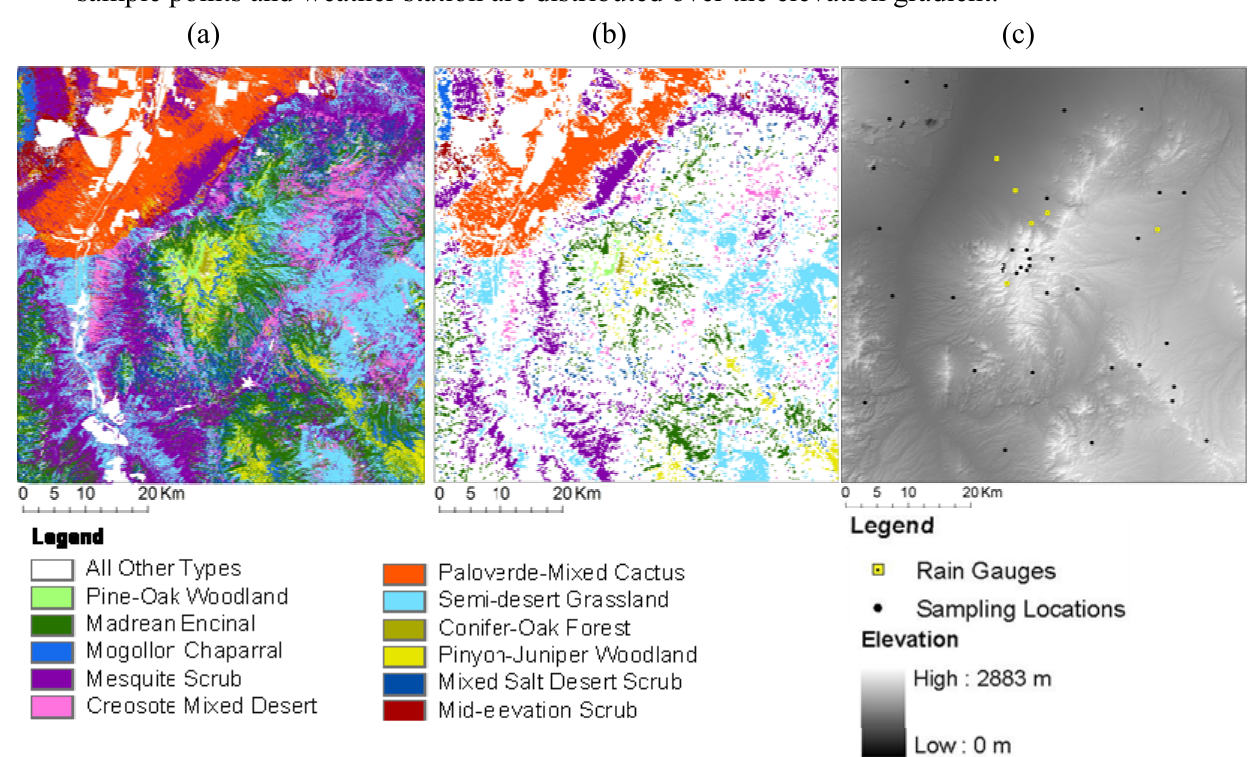
Figure 2. (a) The vegetation communities based on the SWReGAP vegetation cover map are dominated by the 11 (b) communities used in our analysis (see also Table 1). The vegetation community data set was re-sampled to 250 m and filtered for homogeneous sites. White areas/pixels denote either developed urban and agricultural areas, or areas without enough contiguous homogeneous pixels for the analyses. (c) The locations of homogeneous sample points and weather station are distributed over the elevation